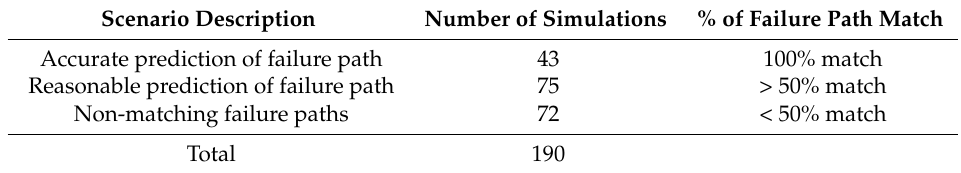
Table 1. Summary of the proposed method to estimate failure paths. Among various failure